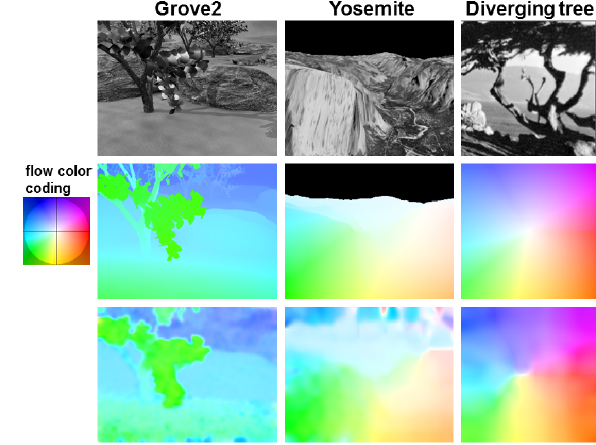
Figure 6: The top row shows the first frame of the input sequences used to our study. The middle row shows the color coded ground truth flow of each image. The bottom row shows the estimated optic flow of our algorithm. In the left-most column we visualize the color coded ground truth flow that indicate speed and